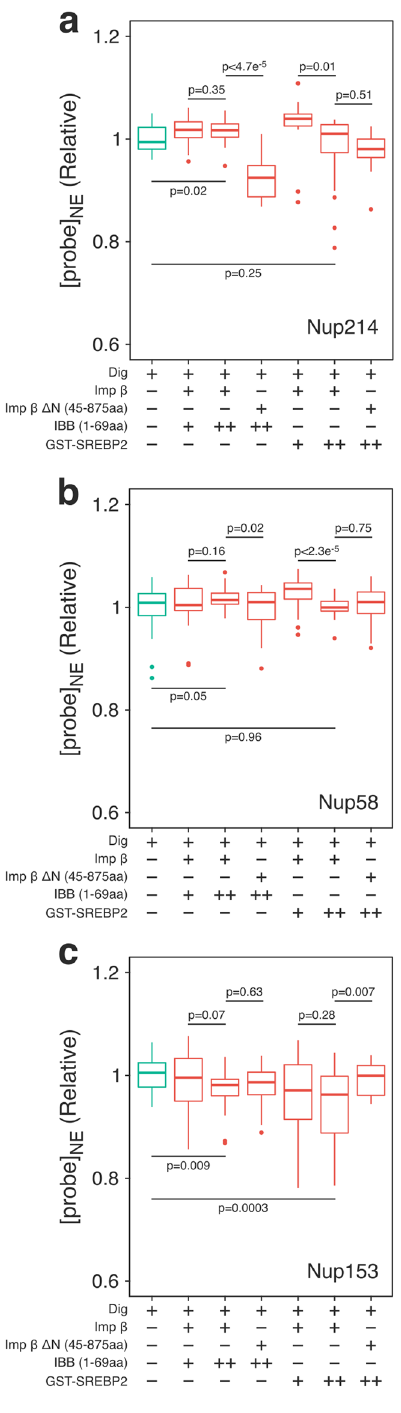
Figure 4. Importin β -dependent nuclear transport affects protein crowding in the NPC. Similar to Fig. 3, HeLa cells expressing GimRET-fused Nups (214 ( a ), 58 ( b ), 153 ( c )) were treated with digitonin (Dig), and incubated with indicated components of the transport; wild-type of importin β (10 μ M), a deletion mutant of importin β (Imp β ∆ N, 45–875aa, 10 μ M), importin β binding domain of importin α (IBB), glutathione S–transferase (GST)–sterol regulatory element–binding protein 2 (SREBP2) ( + : 1 μ M, ++ : 10 μ M), together with RanGDP, NTF2 and ATP regeneration system. The probe signal in the nuclear envelope ([probe] NE ) after incubation was analyzed and shown as the relative value before the incubation. Data are presented as 25% and 75% quartiles; median, bold line; outliers, ○ , from over 20 different cells. P-values are obtained from two-tailed Welch’s